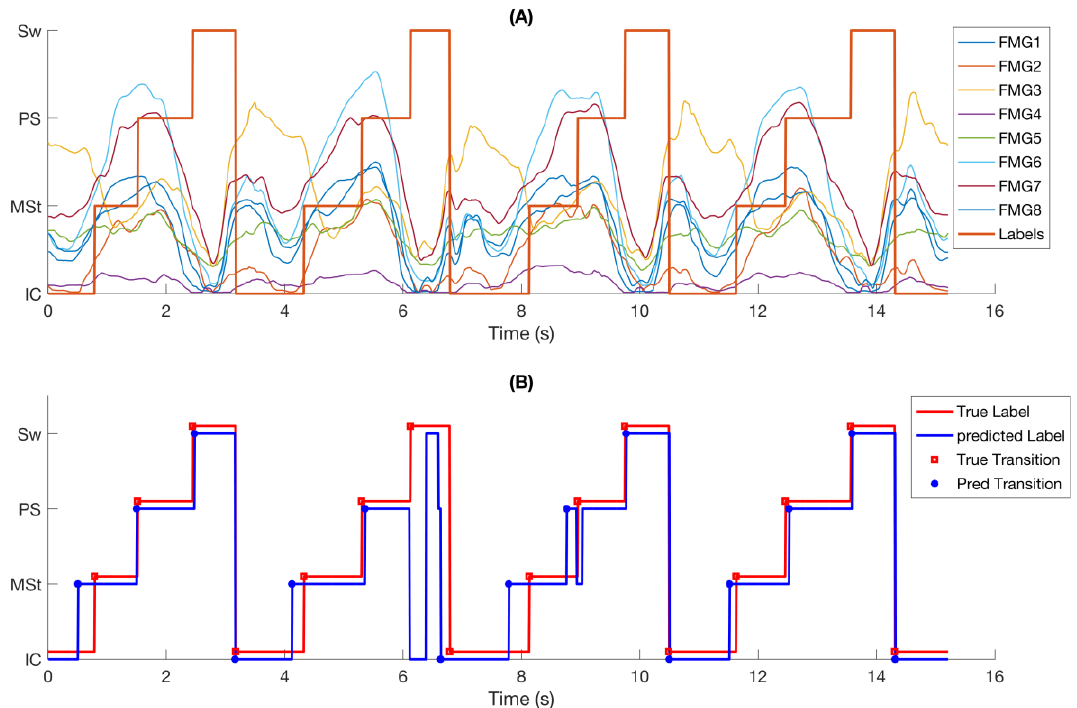
Figure 3. Example FMG raw signals for a segment of 4 gait cycles ( A ) raw FMG signals overlayed with reference labels (red solid line) determined from the recorded video (from subject 5, trial 5, Speed1); ( B ) predicted phase labels (blue solid line) using LDA as well as the true phase transitions and predicted phase transitions after applying supervisory rules. A deletion happens at about 6.1 s.